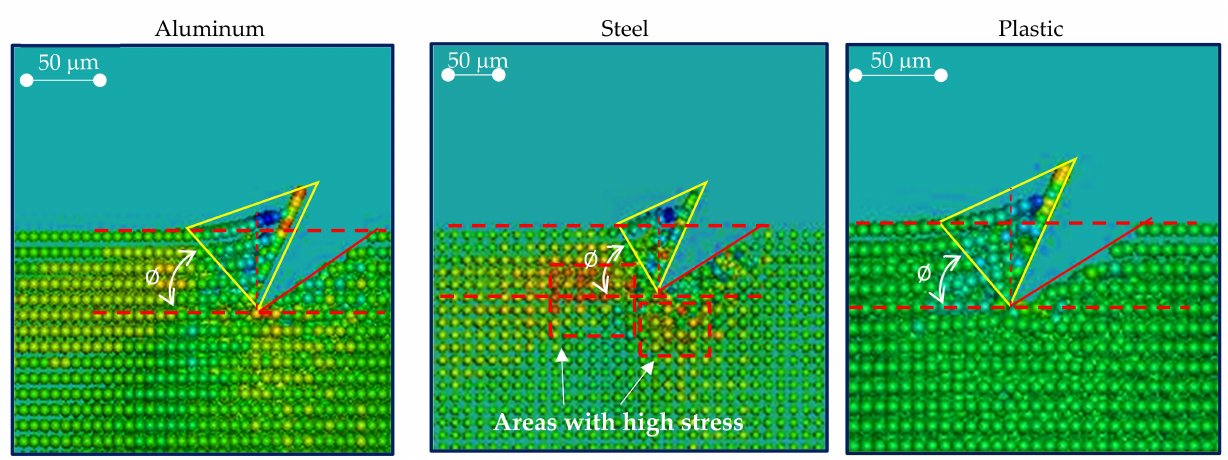
Figure 15. Comparison of the deformed areas for aluminum, steel, and plastic in the simulation with LS-Dyna. Figure 16 shows the force increasing with penetration and the maximum value ob- tained in LS-Dyna for a cutting width of 1